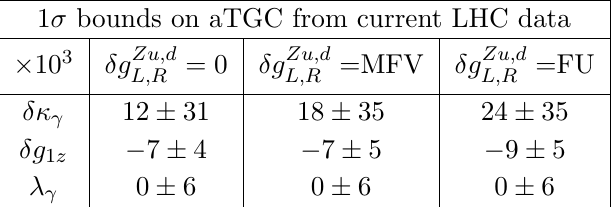
Table 6 . Constraints ( (cid:2) 10 3 ) on the anomalous triple gauge couplings from the current LHC diboson data. The (cid:12)rst column corresponds to the traditional diboson analysis that considers only aTGCs and sets to zero all anomalous fermion-gauge vertices (cid:14)V (cid:22) qq = 0. The next two columns show the e(cid:11)ect of letting these anomalous fermion-gauge vertices (cid:13)oat, assuming either a MFV or a FU setup respectively.